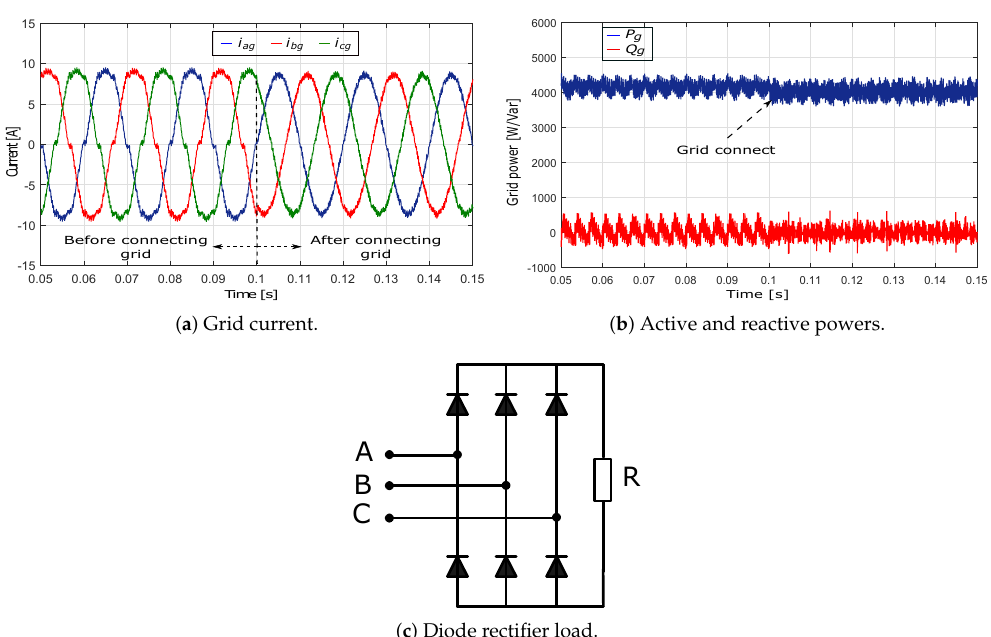
Figure 11. Grid current and power responses with the non-linear